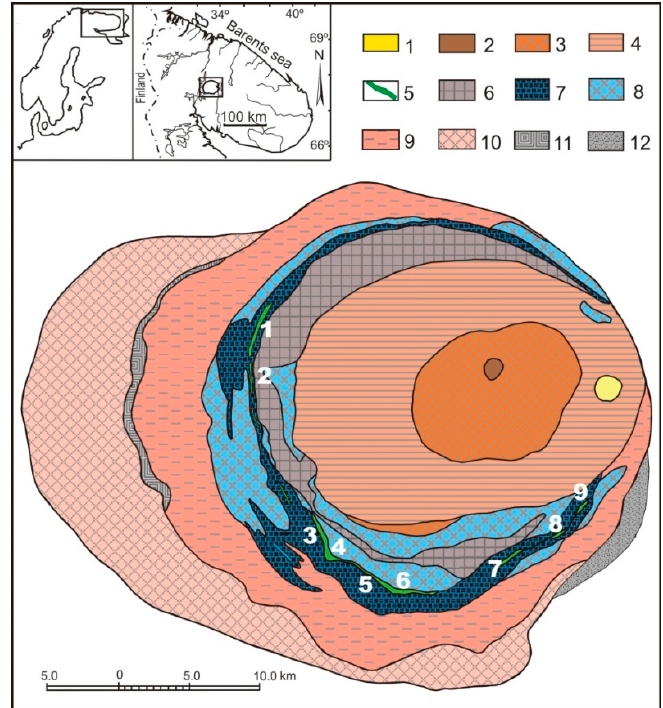
Figure 1. Geological sketch map of the Khibiny massif (based on the map of production geological association